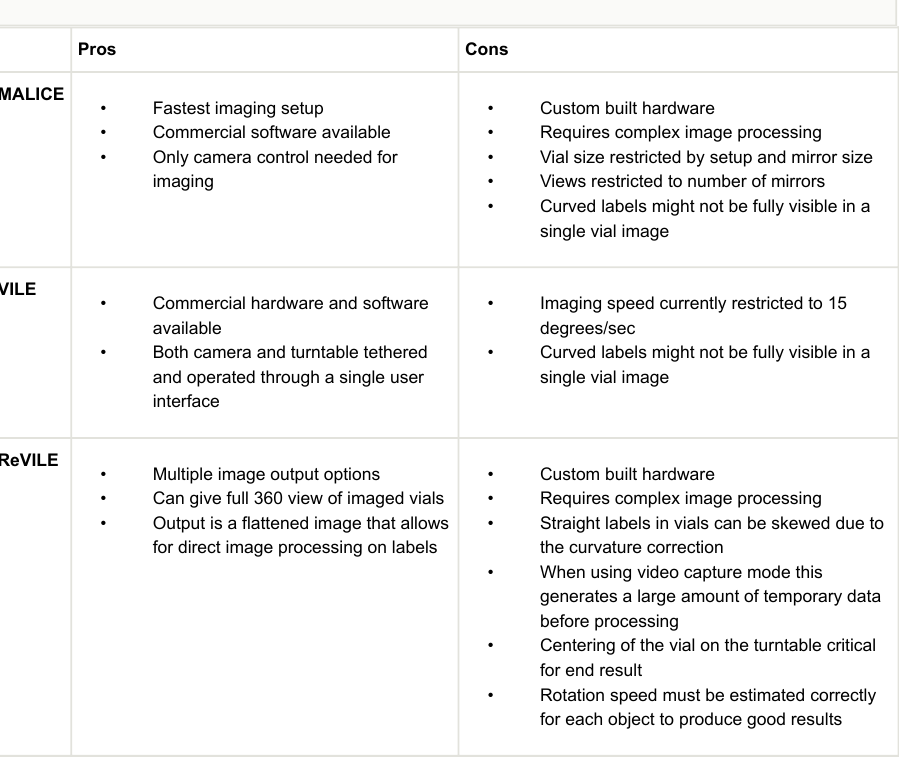
A summary of the pros and cons of the three systems presented.